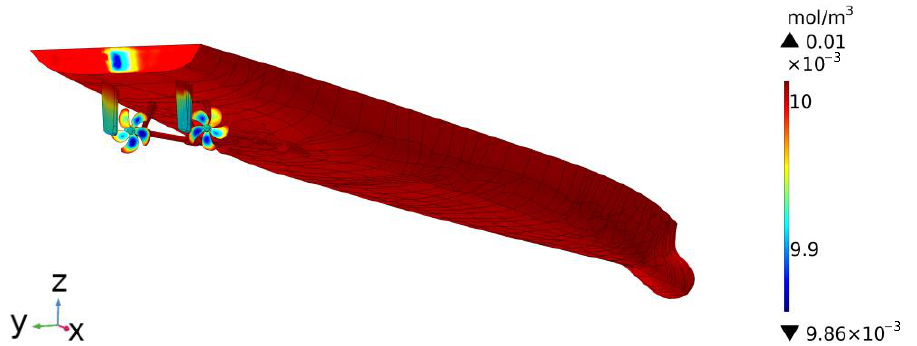
Figure 5. Oxygen concentration distribution on the surface of the ship hull.